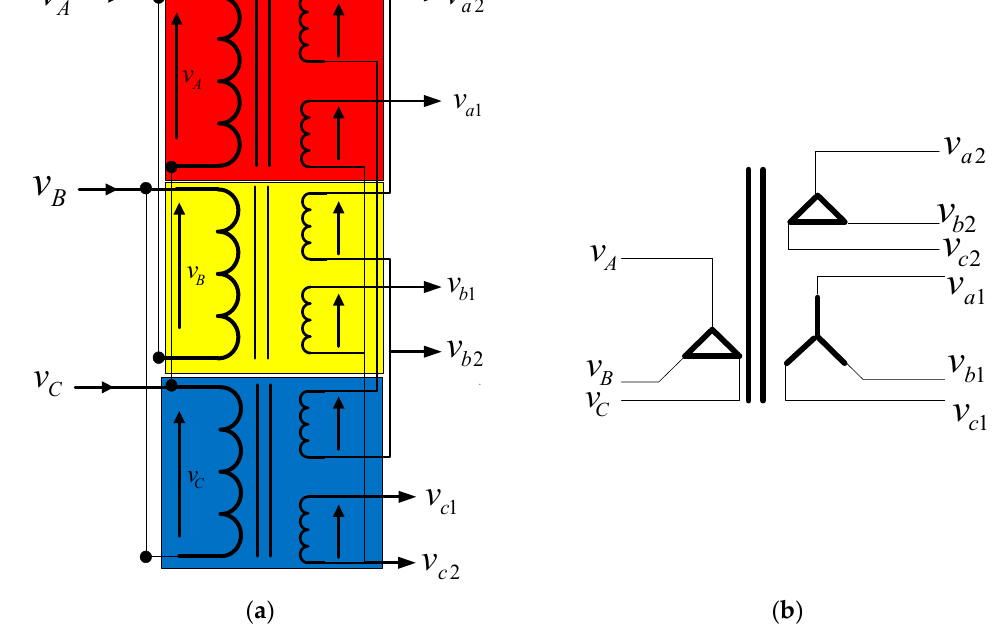
Figure 7. Quasi six-phase output with primary delta; ( a ) connection diagram; ( b ) symbolic representation.